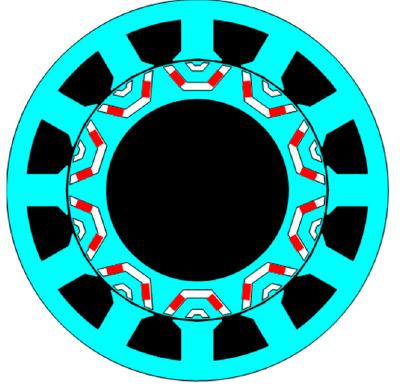
Figure 4. Result of phase current comparison with optimized coefficients.